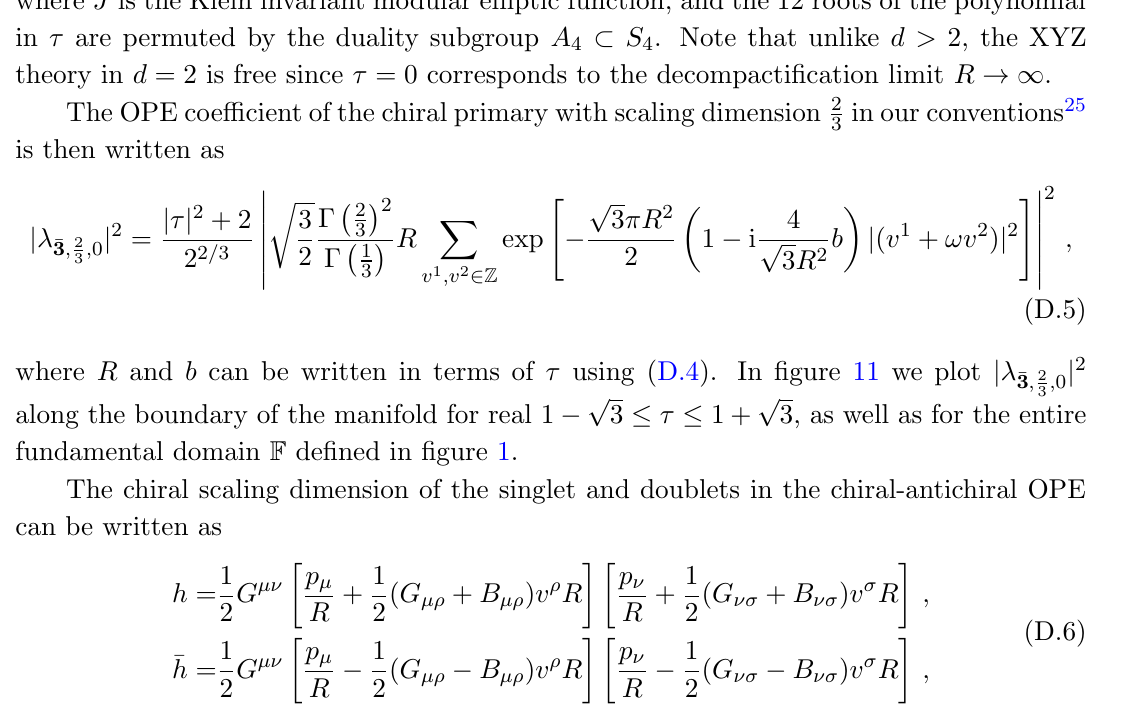
Figure 11 . Exact chiral bilinear OPE coe(cid:14)cient squared (cid:21) 2 ( Left ), as well as for the fundamental domain F de(cid:12)ned in (cid:12)gure 1 ( Right ). The cross and circle denote the enhanced symmetry points (cid:28) = 1